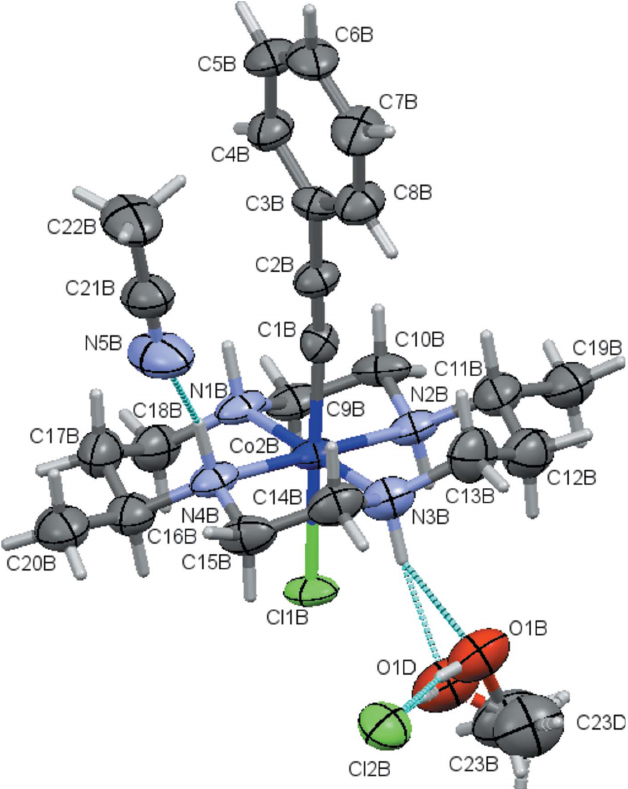
Figure 1 Displacement ellipsoid plot (50% probability setting) for one of the two pseudo-symmetry-related halves of the asymmetric unit of compound 1 , showing the atom-naming scheme and some of the hydrogen-bonding interactions (turquoise dashed lines). Shown is the ‘ B -moiety’, the atom- naming scheme for the ‘ A -moiety’ is equivalent. Labels for H atoms are omitted for